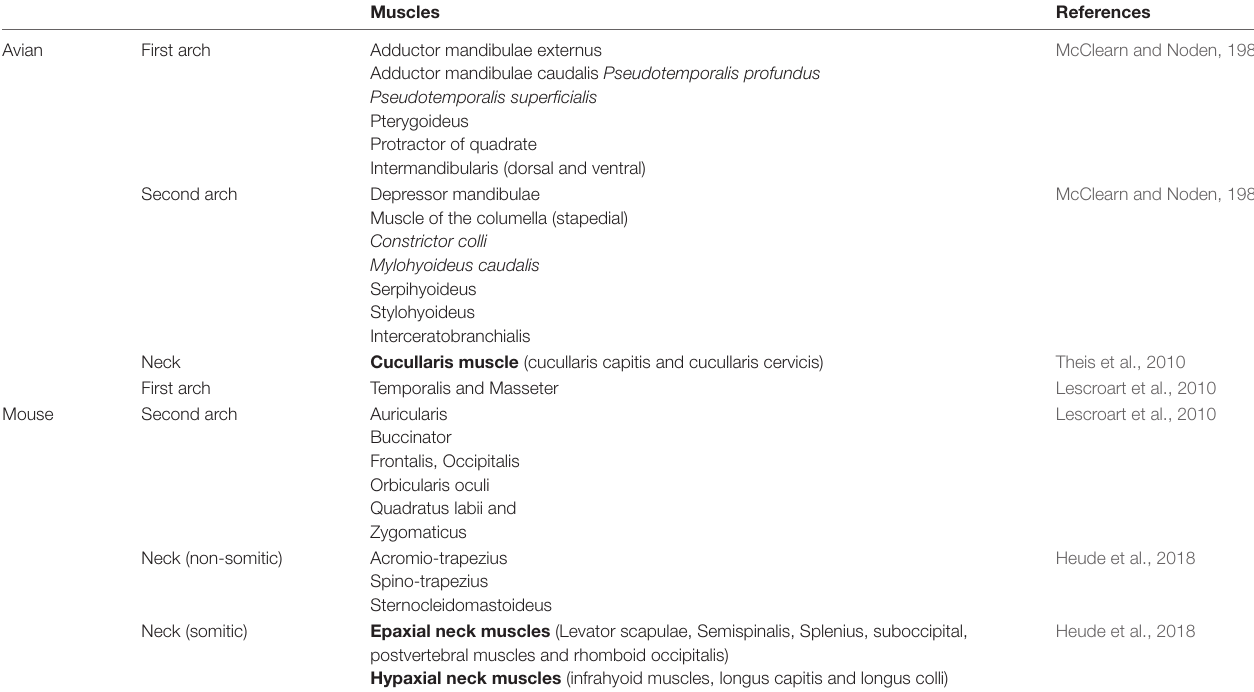
TABLE 1 | Avian and mouse facial and neck muscle.